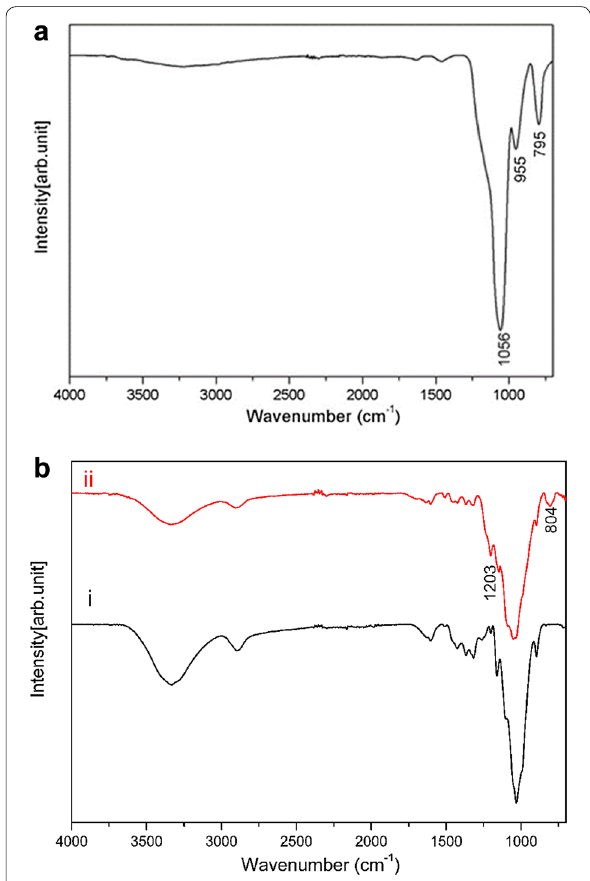
Fig. 4 a FTIR spectra of SiO 2 particles; b FTIR spectra of raw corn straw fiber (i) and prepared superhydrophobic/superoleophilic